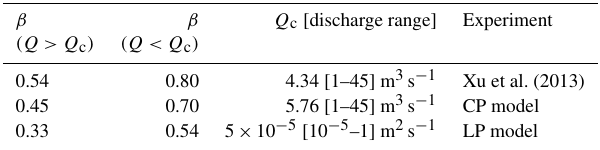
Table 2. Determination of the power law β of melt rate in the equa- tion ˙ m = a · Q β + b . Separation between high (Q > Q c ) and low discharge (Q < Q c ) at a certain discharge Q c .